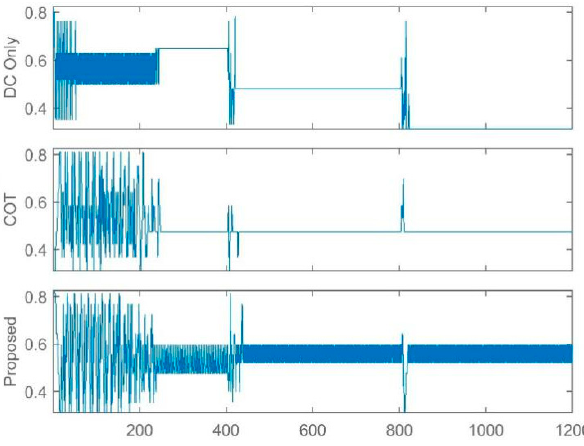
Figure 10. E ffi ciency versus number of Figure 10. Efficiency versus number of steps.